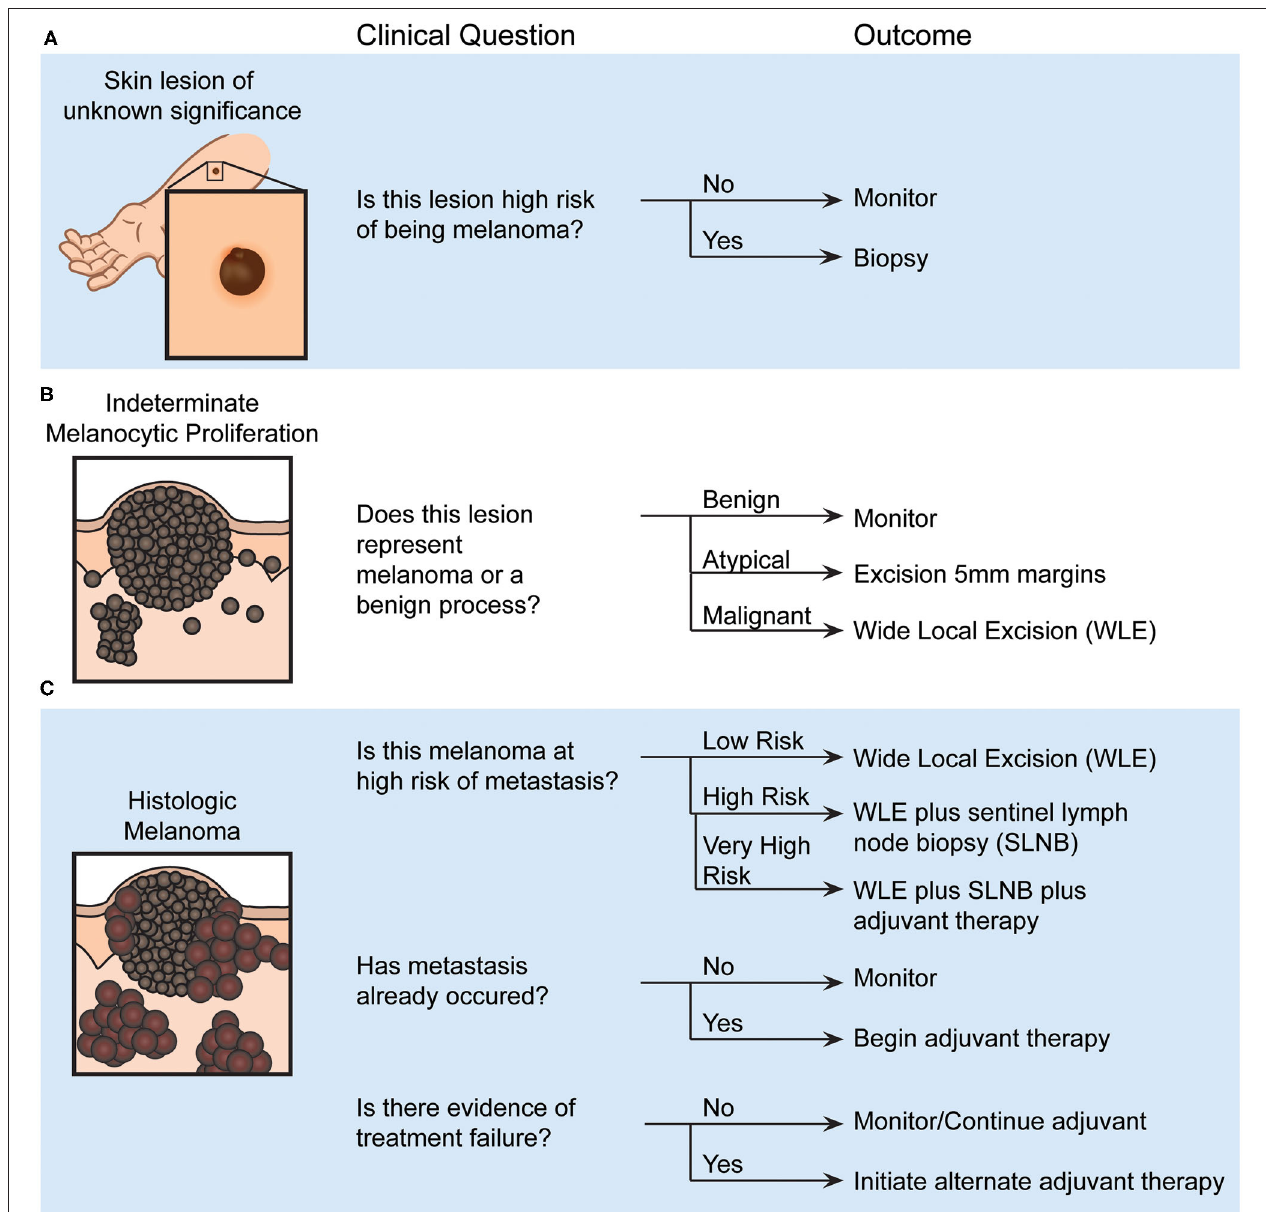
FIGURE 1 | Examples of pigmented skin lesion clinical decision points and their outcomes, which could be aided by validated biomarkers. (A) Assessing a melanocytic lesion of unknown significance will result in a decision to either monitor or biopsy that lesion. (B) After biopsy, the histopathological diagnosis made by a pathologist or dermatopathologist will identify the lesion as a benign, atypical or malignant melanocytic proliferation. This determination will dictate whether the region is monitored or additional surgeries are performed. (C) Recommendations for additional therapy, such as potential sentinel lymph node biopsy and systemic adjuvant therapy, are made based on the estimated risk of metastasis, occurrence of metastasis, and evidence of treatment